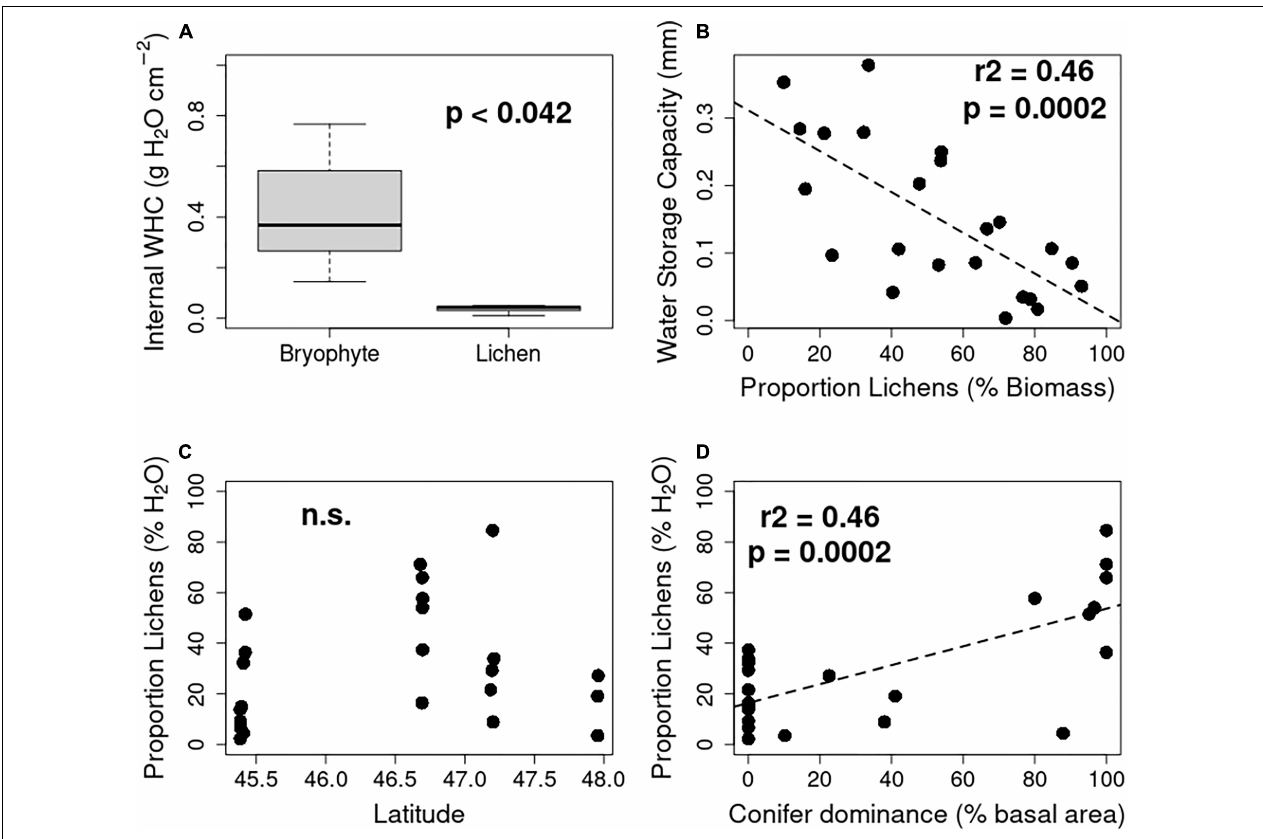
FIGURE 3 | Contrasting impacts of bryophytes and lichens on potential canopy water storage. Bryophytes tended to have greater internal water holding capacity across all functional groups (A) , leading to a negative relationship between lichen dominance and potential water storage (B) . Lichen dominance of epiphyte communities was not explained by latitude (C) but increased significantly in conifer dominated stands (D) . n.s., not significant at p <